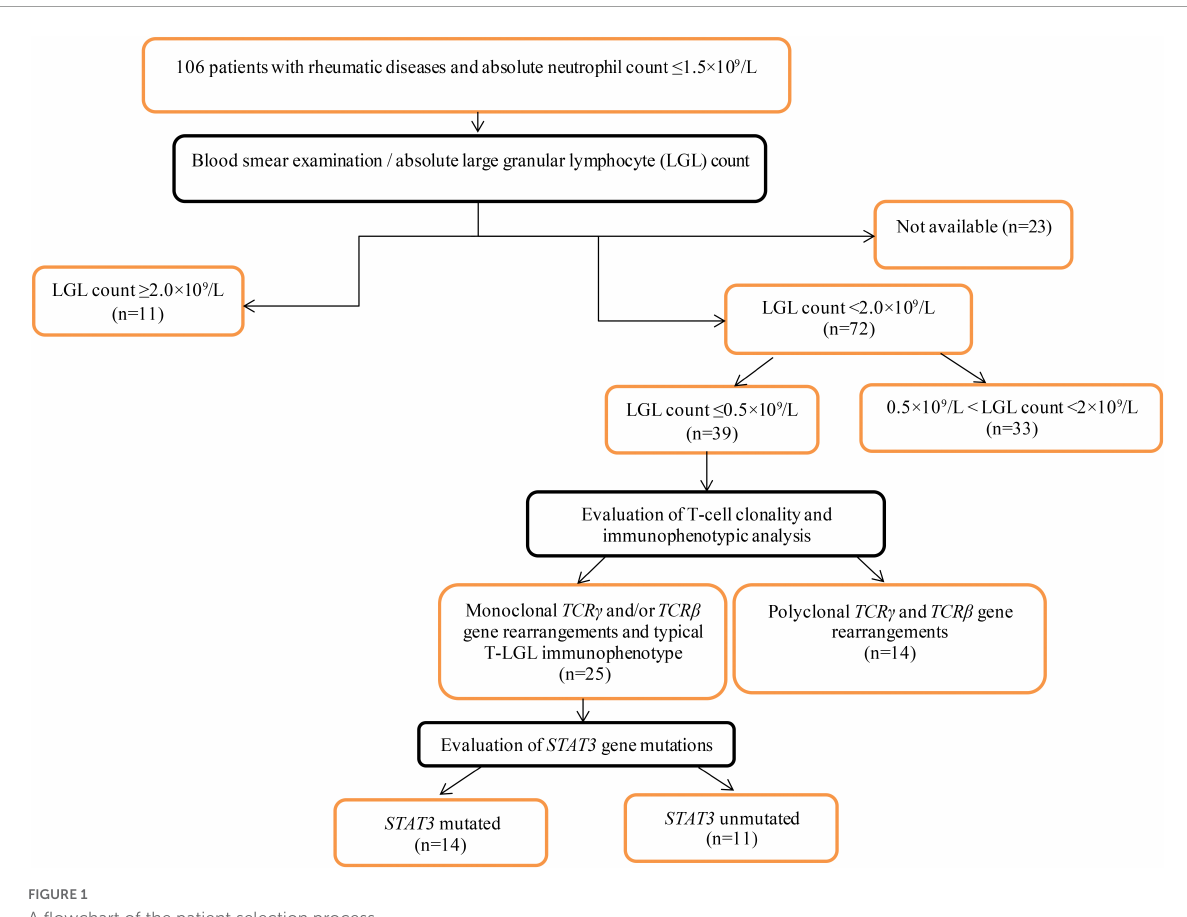
FIGURE1 A flowchart of the patient selection